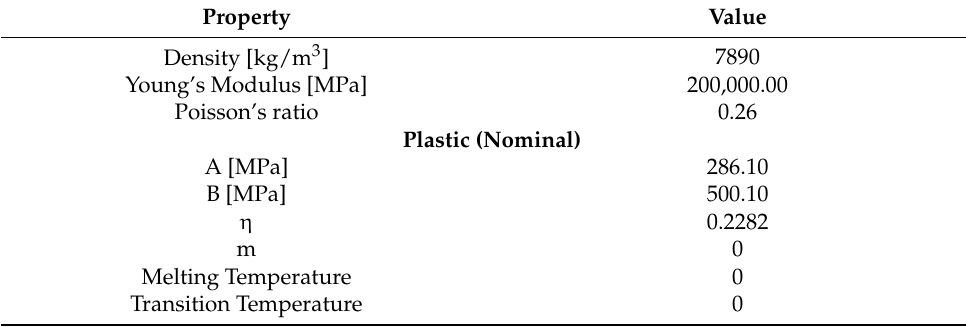
Table 3. Mechanical properties of ASTM A36 steel used for the chassis